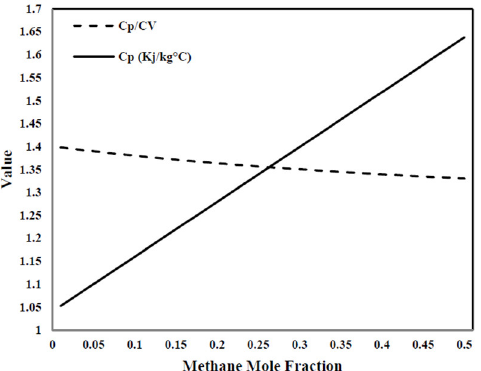
Figure 24. The variation of C p and C p /C v in different mole fractions of methane in the mixed refrigerant at standard conditions [87]. Reproduced with permission from Elsevier (license number 5413441330596).